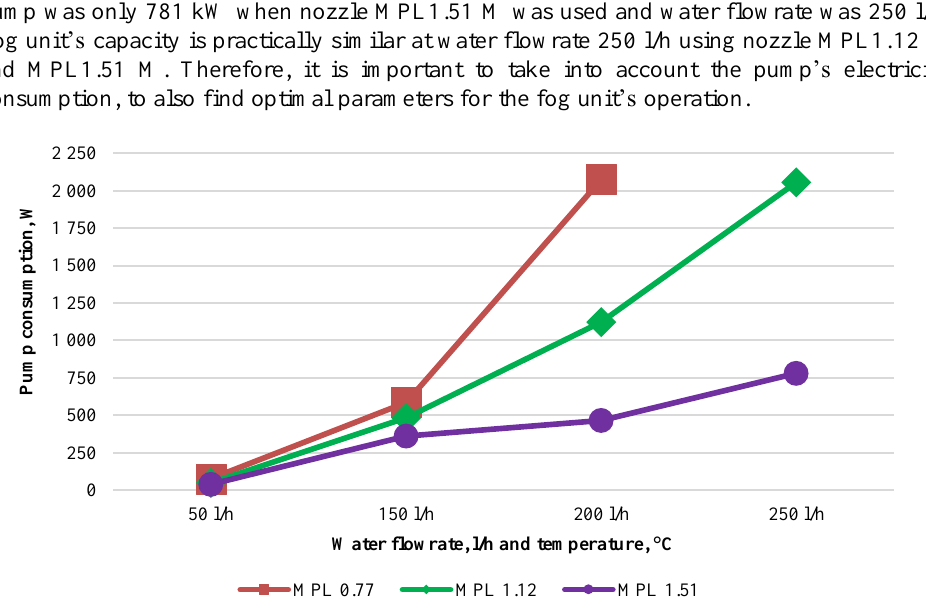
Fig. 4. Effects of nozzle size, sprayed water amount and temperature on pump’s electricity